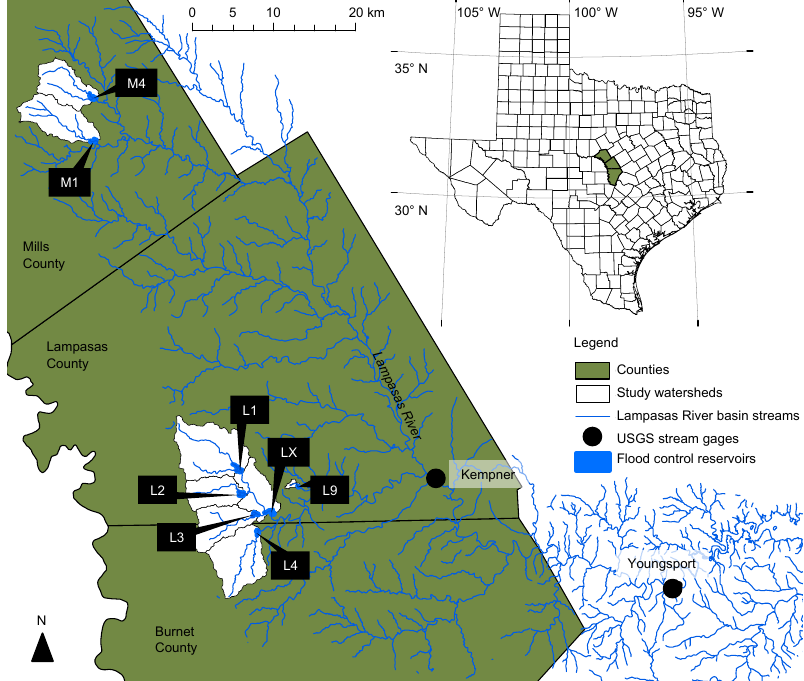
Figure 1. Study area in Texas, USA. Each study watershed encloses a flood-control reservoir from which sediment cores were collected. All watersheds contribute flow to the Lampasas River. Table 1. Sediment study reservoirs and watershed characteristics.